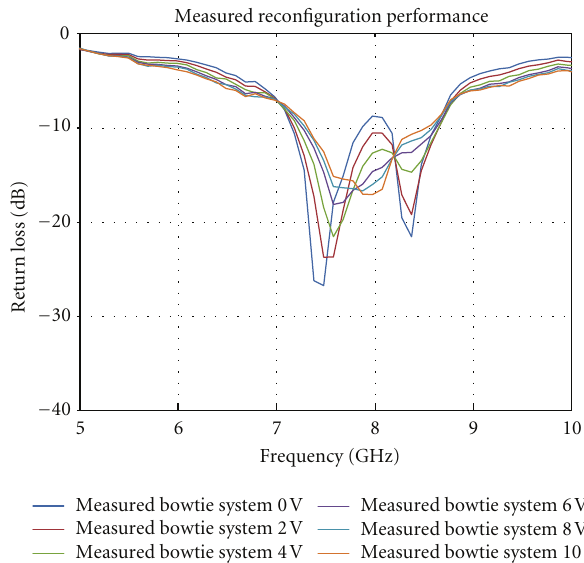
Figure 7: Measured swept frequency S 11 of the antenna system under 0–10 V DC bias.